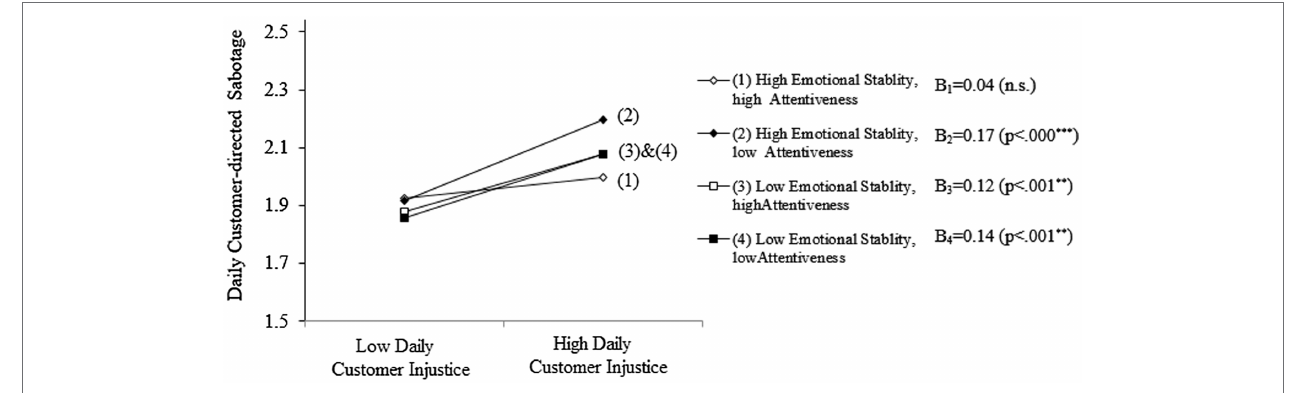
FIGURE 2 | Three-way